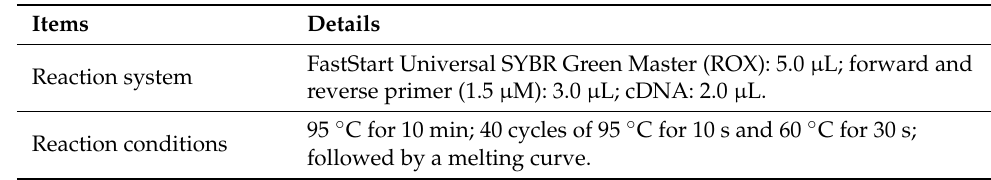
Table 2. RT-qPCR reaction system and